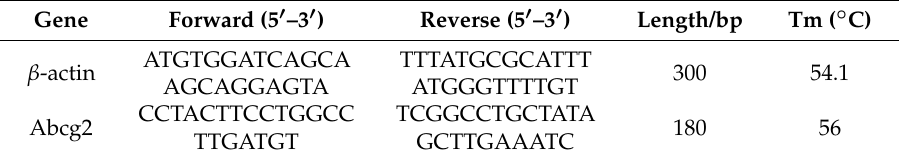
Table 5. Nucleotide sequences of the primers used for real-time quantitative PCR